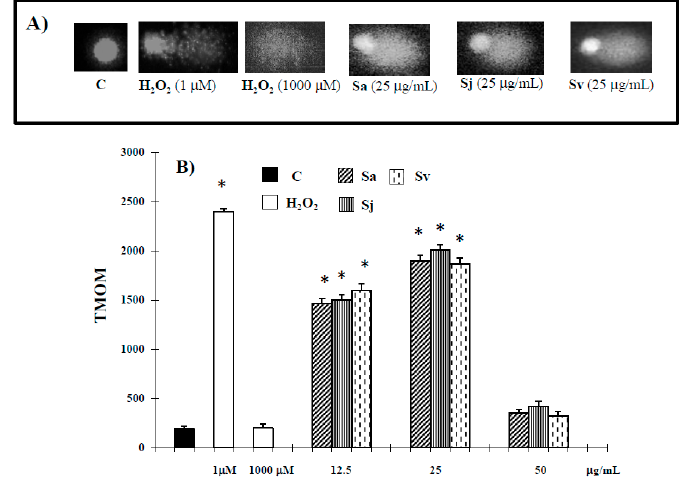
Figure 3. Comet assay of genomic DNA in DU-145 cancer cells untreated and treated with the essential oils from Sa, Sj and Sv for 72 h. Representative photomicrographs of microgel electrophoresed genomic DNA of untreated and treated cancer cells ( A ). TMOM values ( B ). TMOM = tail moment expressed as the product of TD (distance between head and tail) and TDNA (percentage of the fragmented DNA). The values are the mean ± standard deviation (SD) of three experiments performed in quadruplicate. * Significant vs. control untreated cells ( p < 0.001).